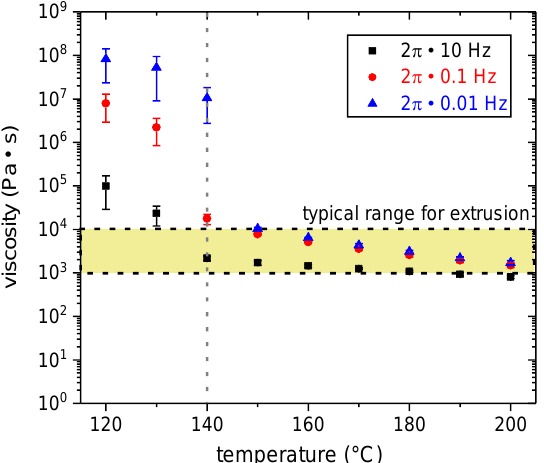
Figure 5. Temperature dependence of the viscosity for three different shear rates (ω = 2 π ∙ 10 Hz, 2π ∙ 0.1 Hz, 2π ∙ 0.01 Hz). The typical processing viscosity range for extrusion (10 3 – 10 4 Pa ∙ s cf. e.g., [36]) is marked.